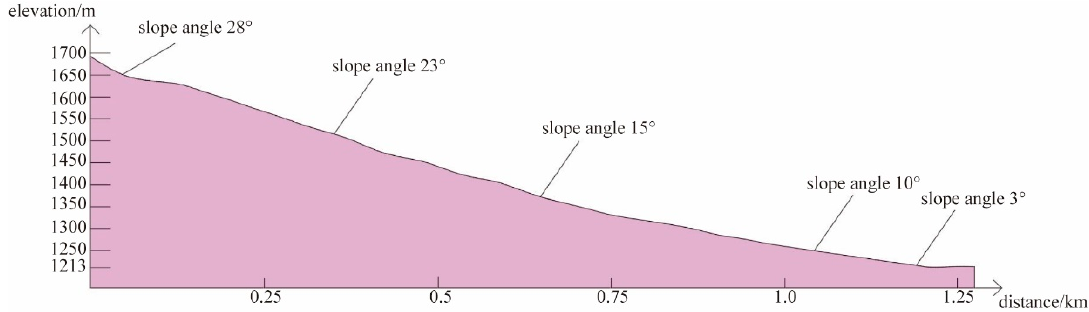
Figure 3. Cross ‐ section of the slope before the landslide obtained by Google Earth (location is shown in Figure 4b).